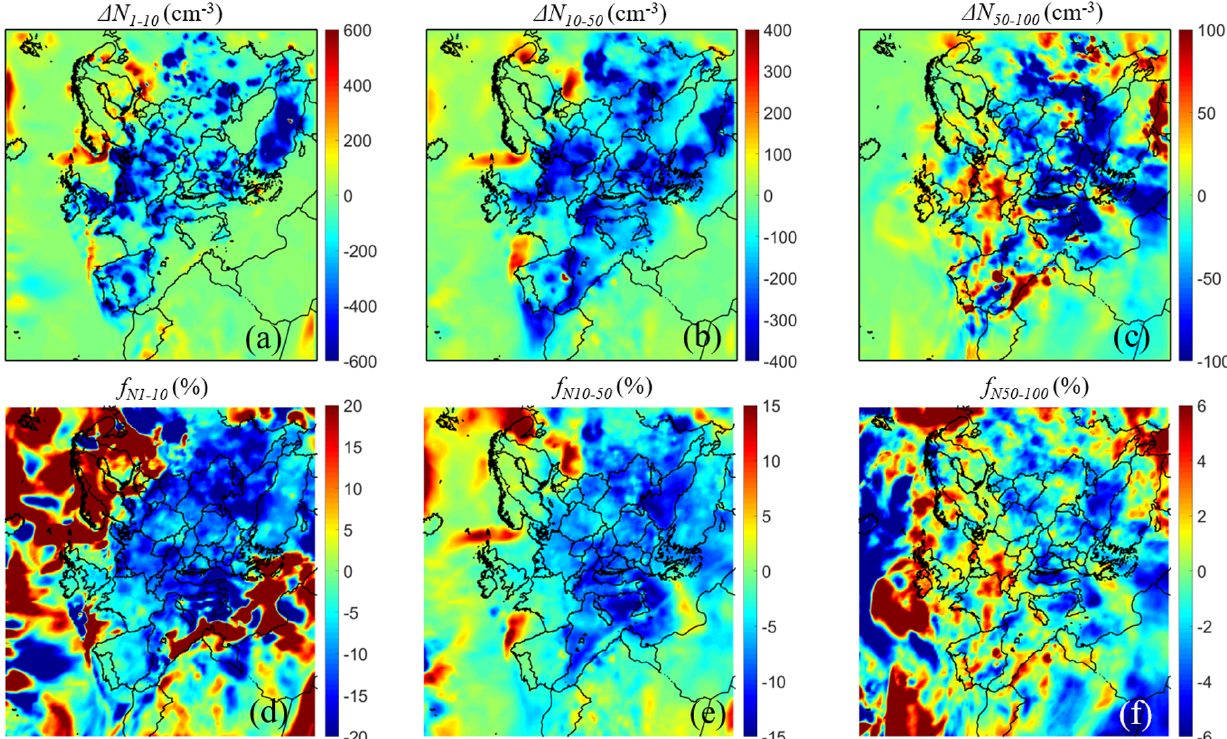
) in number concentration (d– x